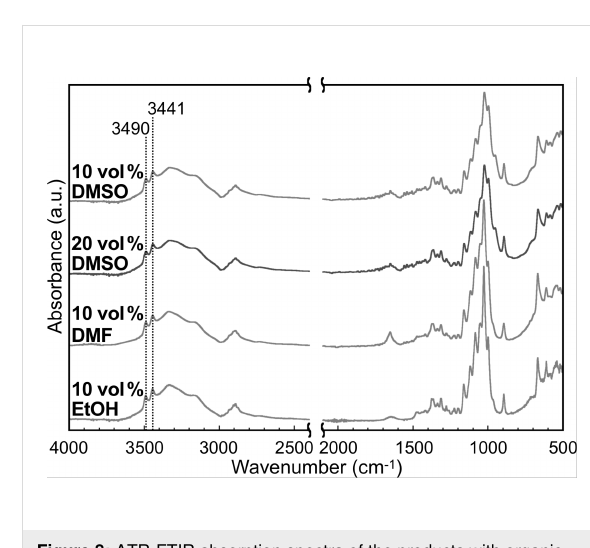
Figure 8: ATR-FTIR absorption spectra of the products with organic solvents. The numbers above the peaks denote the